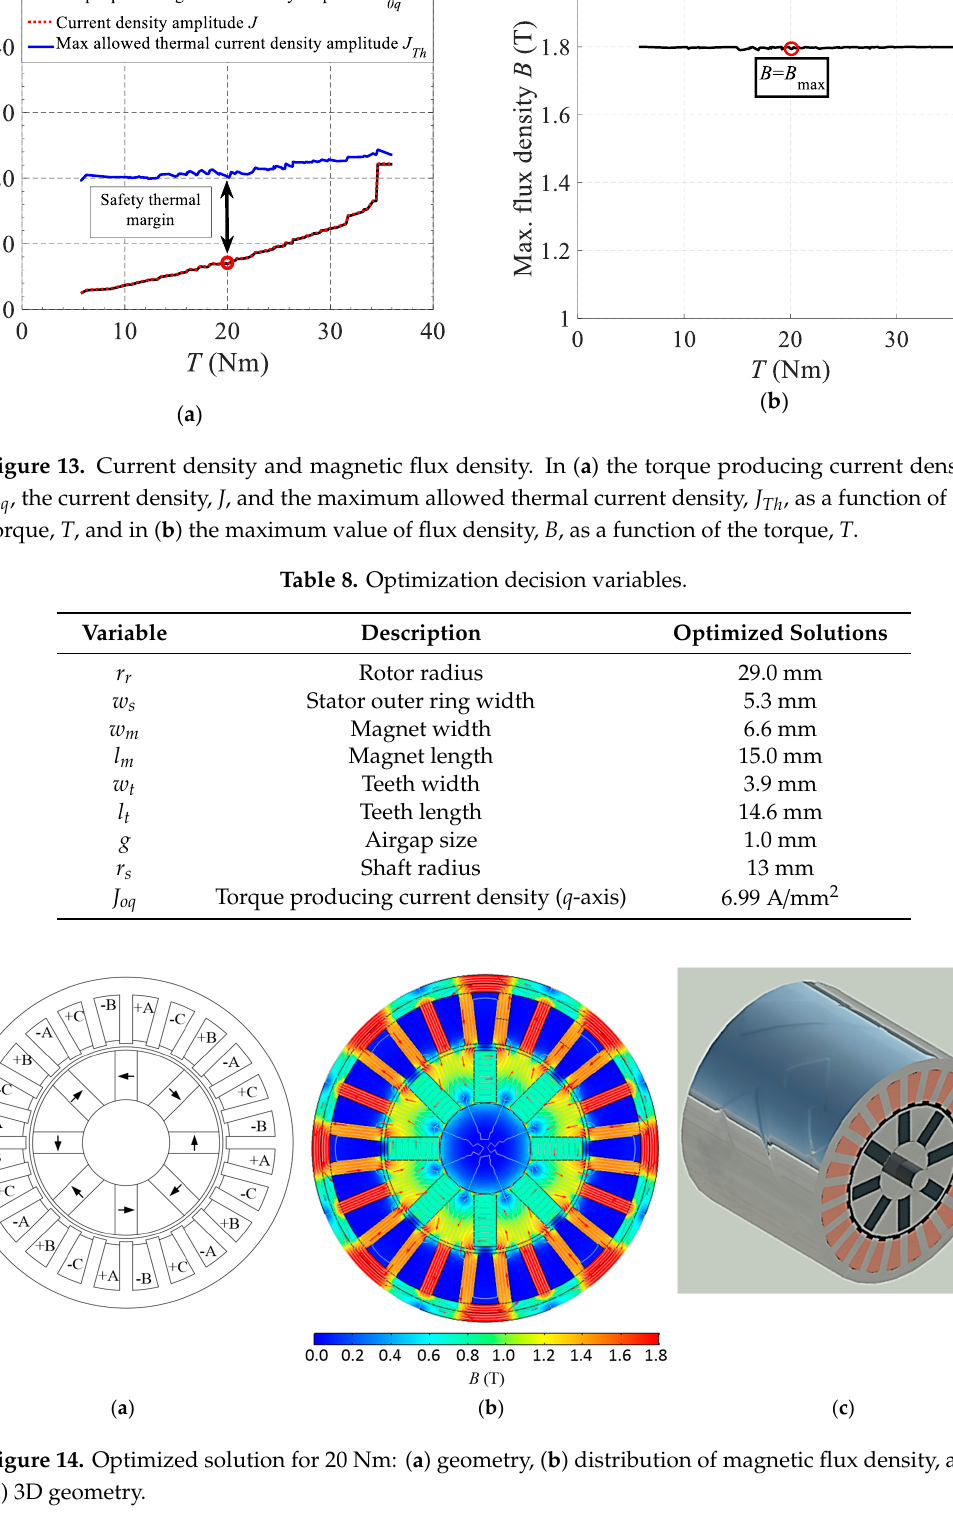
( c ) Figure 15. Optimized solution's induction coefficients (a) 𝐿 (cid:3031) , (b) 𝐿 (cid:3044) , and (c) permanent magnet linked flux 𝛹 (cid:3017)(cid:3014) . The torque map is estimated from these with (5) limited to the optimum torque producing current density 𝐽 (cid:3042)(cid:3044) = 6.99 MA/m (cid:2870) (I = 33 A) , corresponding to the required 20 Nm, Figure 16a. In this case, the efficiency map, Figure 16b is obtained for the operation points following the maximum torque per ampere (MTPA) strategy from (3)–(7). These points are presented in Figure 16a representing the constant torque and field weakening regions. The MTPA trajectory on the constant torque region shows small I d = 5A at 20 Nm, meaning that reluctance torque is not a considerable component. This stems from the optimization being based on the maximization of the electromagnetic torque component. As seen in Figure 16b the field weakening region occurs from 8000 rpm onwards.